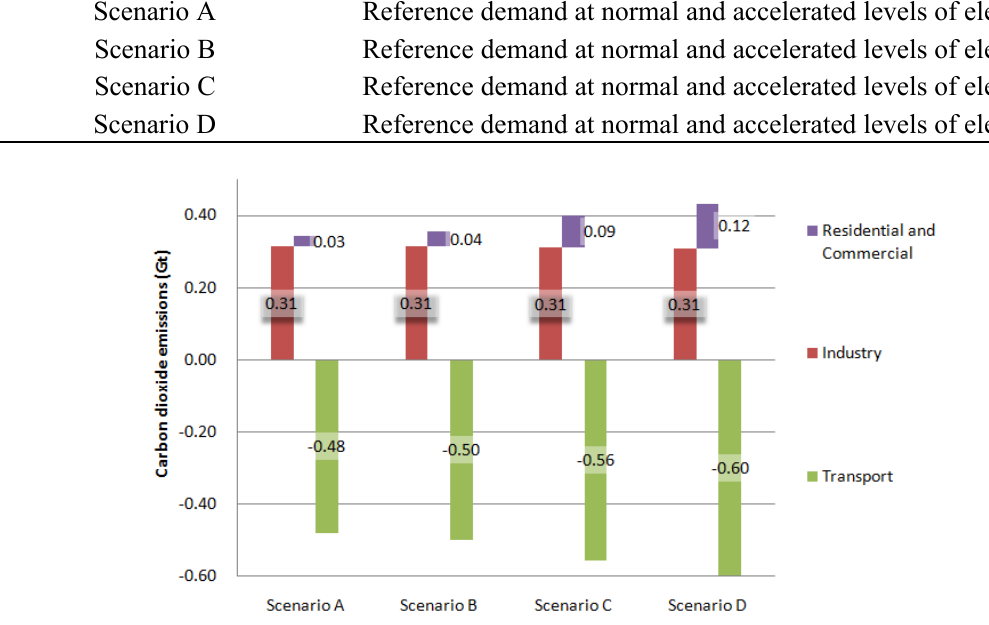
Figure 11. Changes of emissions by implementing two electrification levels in different low-carbon supply